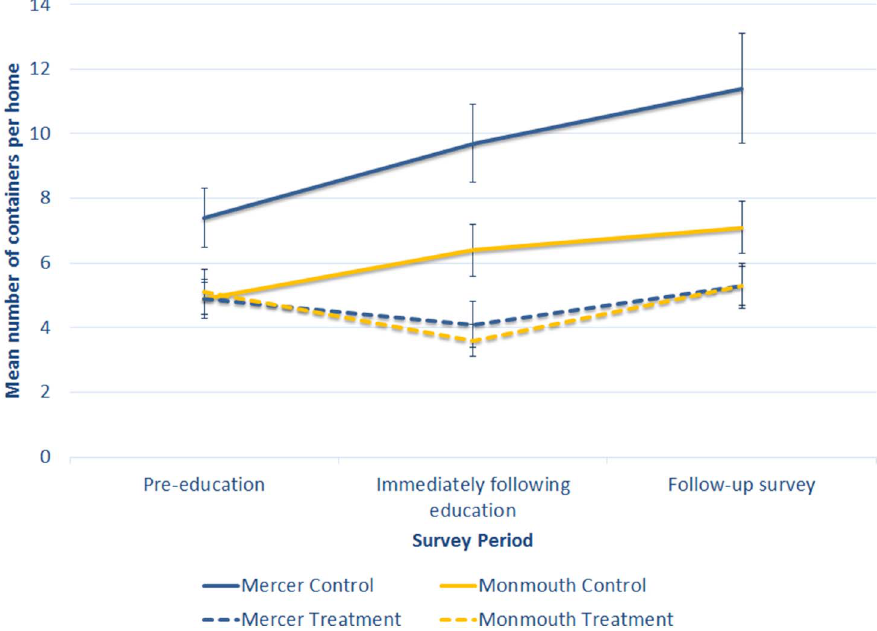
Figure 2. Mean number of unmanaged containers per homes ( 6 SE) in sites receiving active education (Treatment site), versus those not receiving education (Control site). The Mercer County data is represented in blue, and the Monmouth County data represented in yellow. Treatment sites are represented by the dashed lines, and control sites by the solid lines.